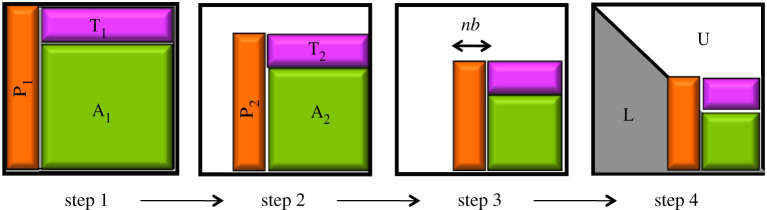
Schematic representation of the LU factorization process.(Online version in colour.)